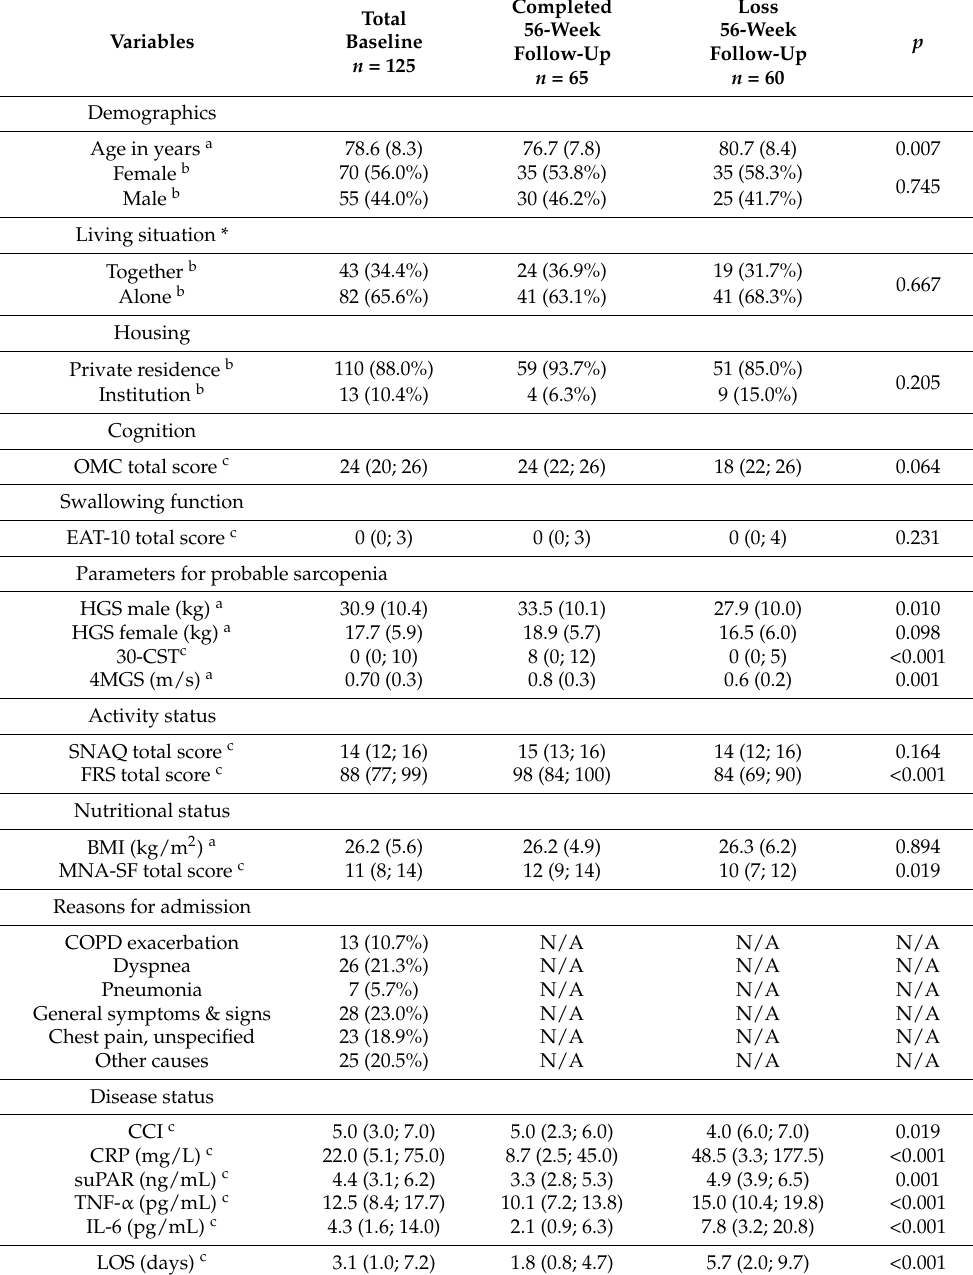
Table 1. Characteristics of the FAM-CPH